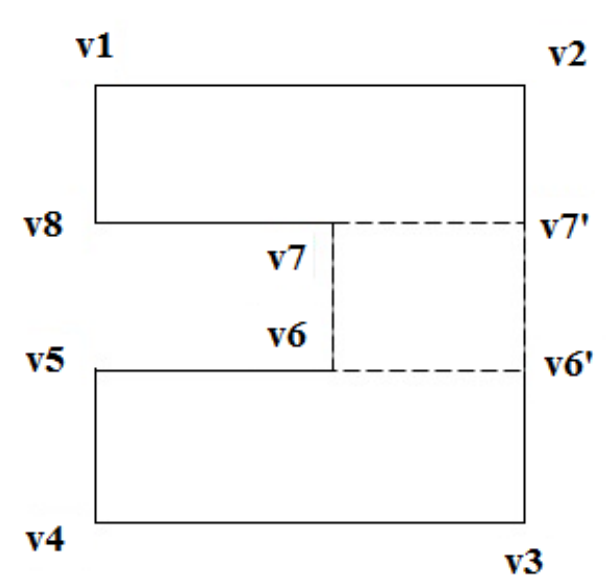
Figure 10. Non-convex polygon divided into convex polygons.